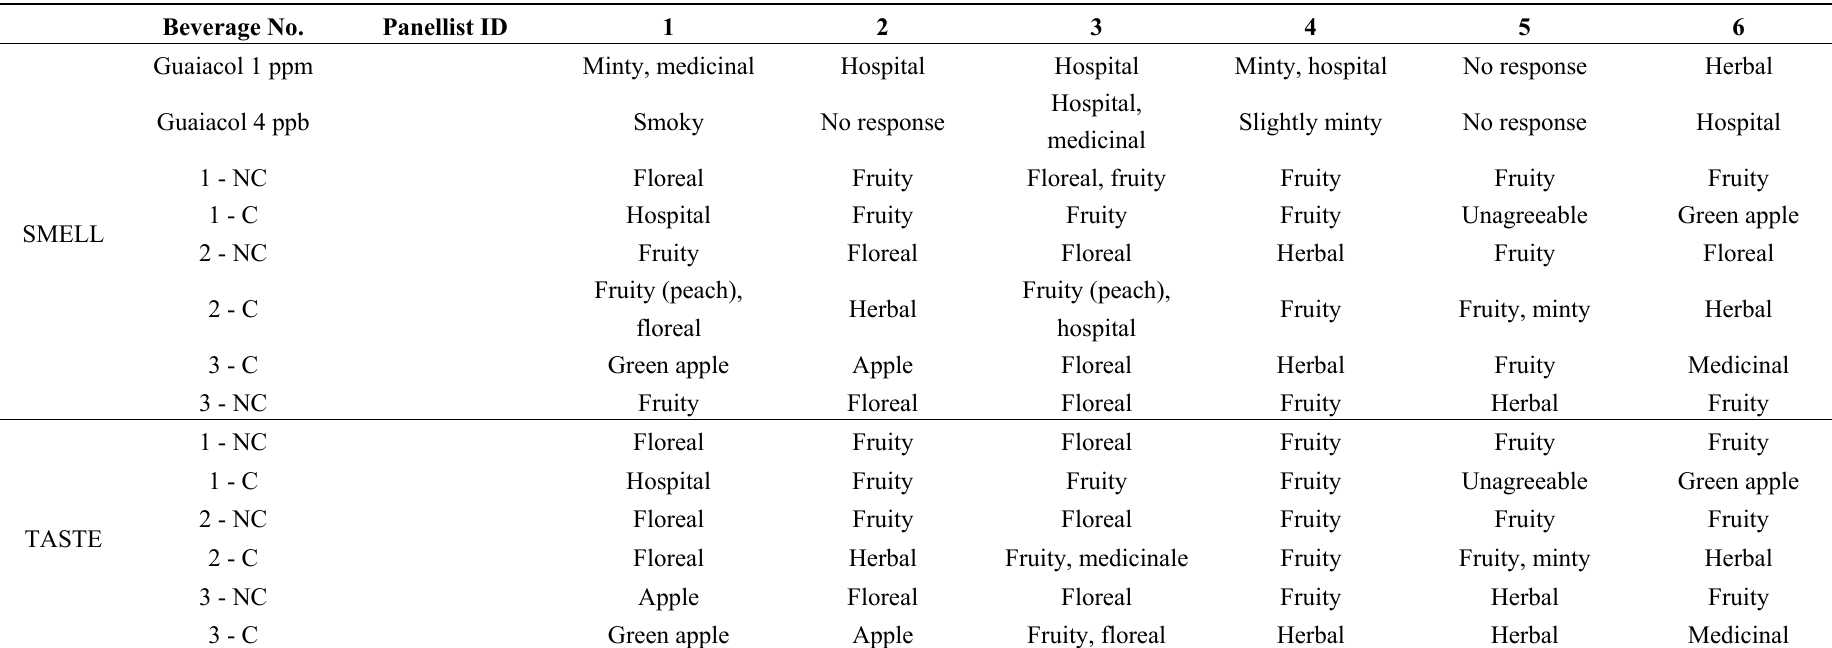
Table 1. Results of informal panel test carried out on soft drinks uncontaminated and contaminated by ACB. Beverage numbers correspond to: 1 peach juice-based, 2 pear juice-based, 3 apple juice-based. Reprinted from [45] with permission of Elsevier Food Research International, copyright